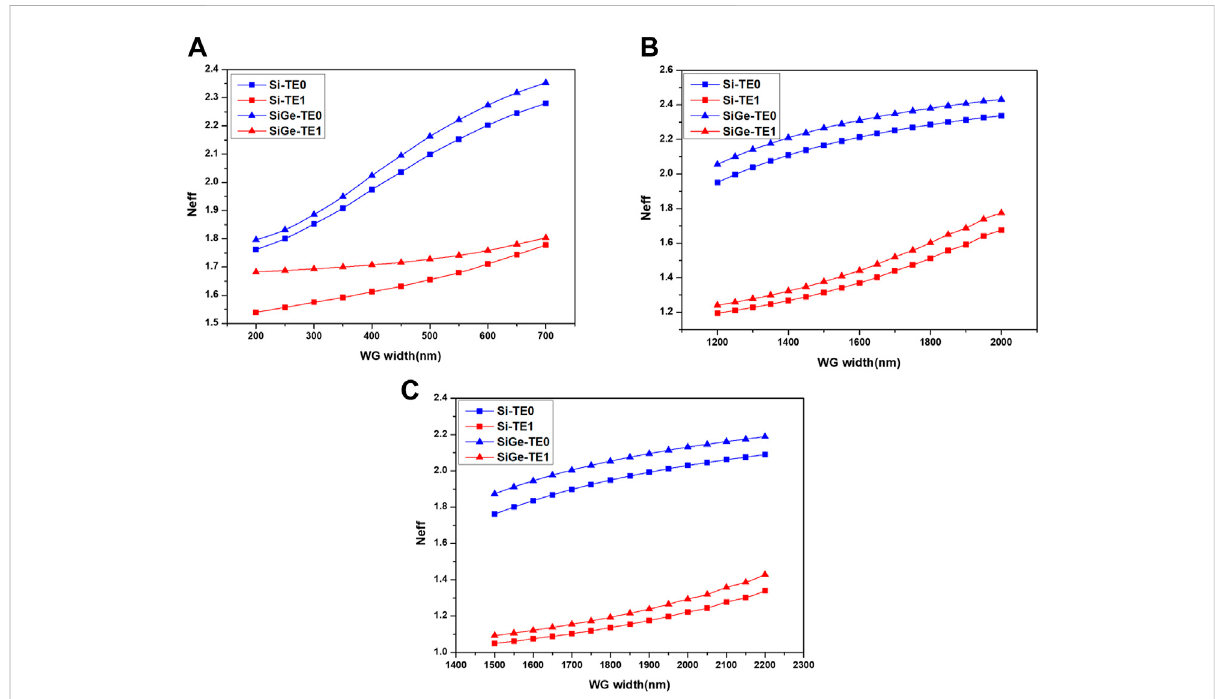
Simulation curves of effective refractive index and ridge width of Si waveguide and SiGe waveguide at (A) 2 μ m wavelength, (B) 4.3 μ m wavelength and (C) 5 μ m wavelengths.